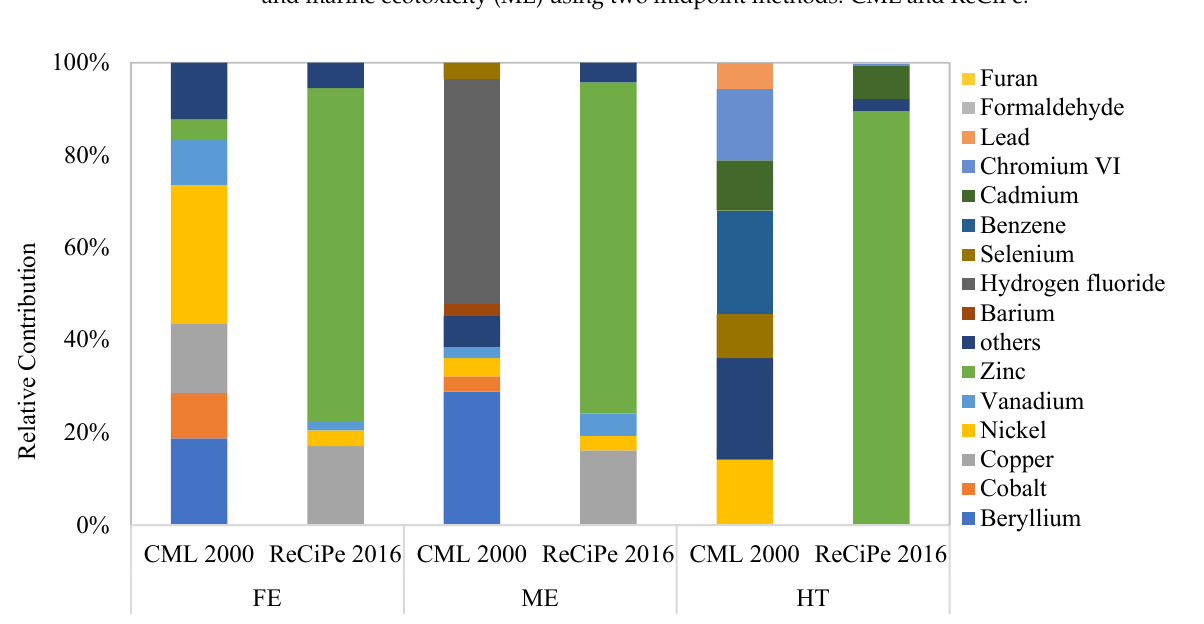
Figure 4. Contribution of environmental impacts on human toxicity (HT), freshwater ecotoxicity (FE), and marine ecotoxicity (ME) using two midpoint methods: CML and ReCiPe.